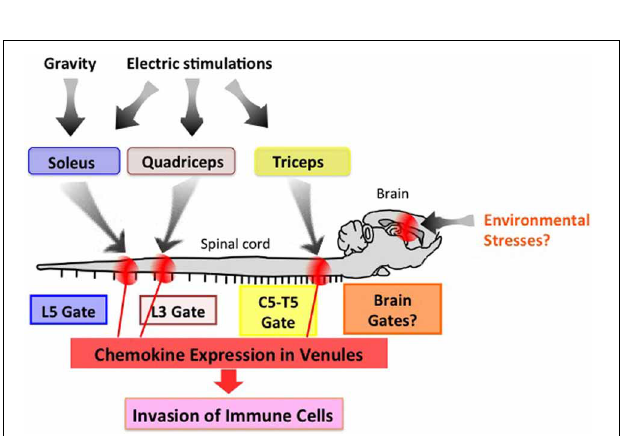
FIGURE 4 | The gateway theory. Electric pulses to the upper arm, thigh, and soleus muscles induce activation of the inflammation amplifier (chemokine upregulation), thereby opening a gate in the dorsal vessels of the fifth cervical to fifth thoracic (C5-T5), third lumbar (L3), and fifth lumbar (L5) cords, respectively. Environmental stresses such as those from social interactions and mental stresses might create a specific gate in the brain. This effect is potentially an attractive target for manipulating immune cell migration in vivo